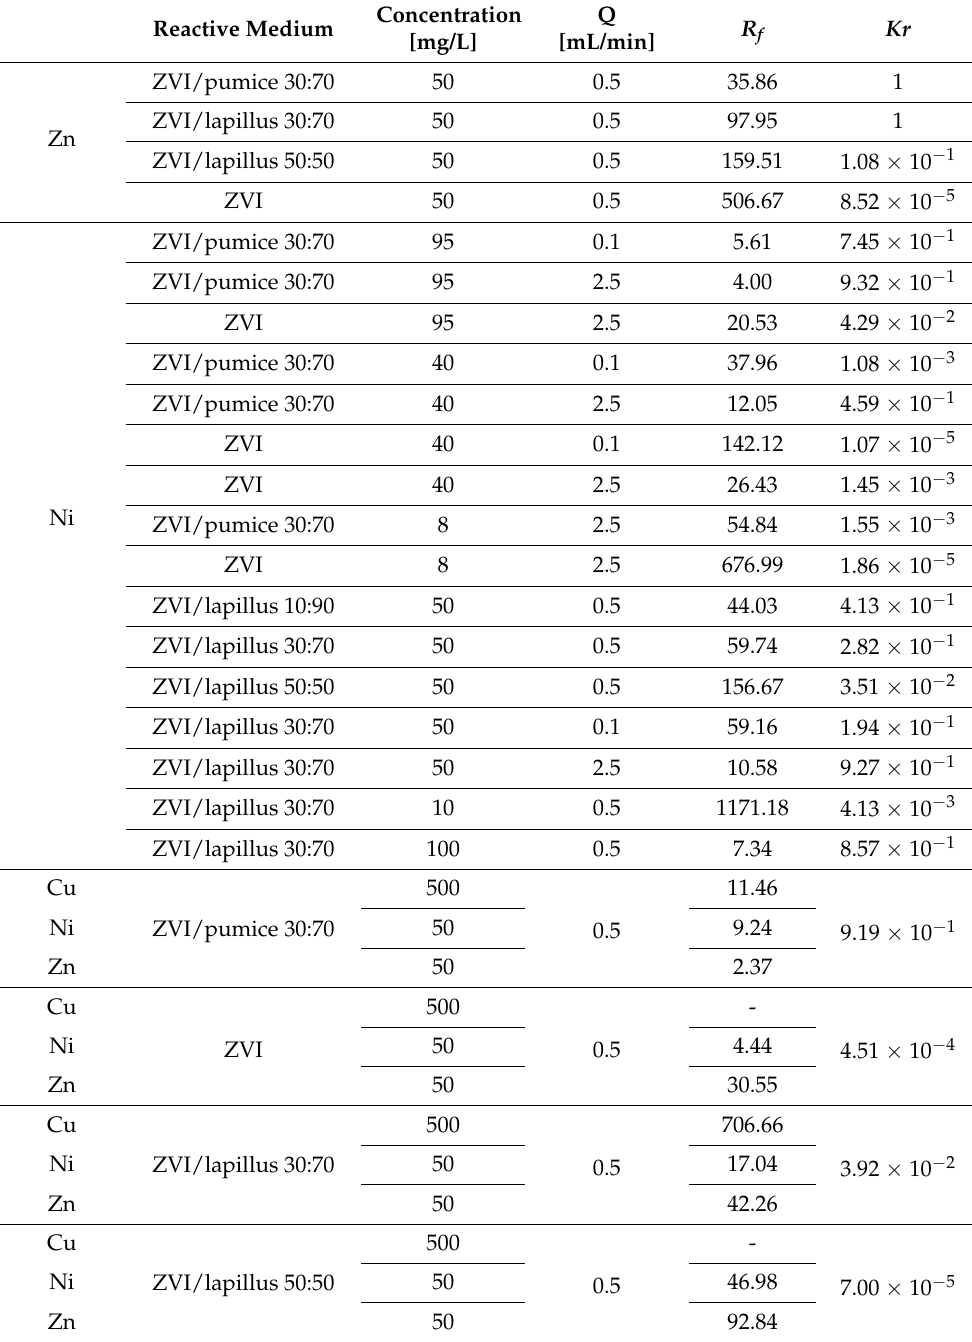
Table 2. R f and Kr values calculated for each column test. Reactive